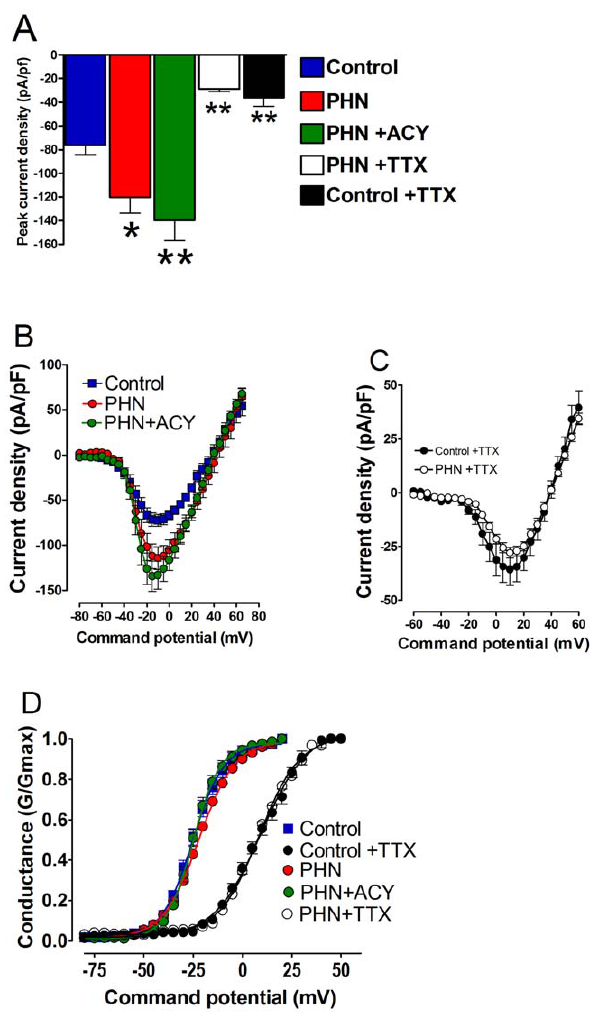
Figure 5. Pre-treatment with acyclovir does not prevent the TTX sensitive increase in sodium current density in ND7/23 1.8 cells induced by prior exposure to VZV isolates implicated in PHN. (A) Comparison peak current density in sham treated control cells (solid blue bar), cells exposed to VZV isolates implicated in post herpetic neuralgia (PHN, solid red bar), cells exposed to PHN VZV isolates and subsequently treated with acyclovir (solid green bar), the effect of TTX on cells exposed to PHN VZV isolates (open bar) and the effect of TTX on sham treated control cells (solid black bar) (sham treated control vs PHN * =p , 0.05; sham treated control vs PHN + ACY ** =p , 0.01; PHN vs PHN + TTX ** =p , 0.01, and sham treated control vs sham treated control + TTX ** =p , 0.01; Analysis of Variance Newman-Keuls multiple comparison post hoc test. (B) and (C) Conventional current density verses membrane potential plots for sodium currents from cells exposed to PHN VZV isolates vaccine strains: sham treated control cells (blue squares) and sham treated control cells following exposure to TTX (black circles); cells exposed to PHN viral isolates in the absence (red circles) and presence of TTX(open circles); and cells exposed to PHN viral isolates that had been pre-treated with acyclovir (green circles). Data was generated using the following protocol: V Hold = 2 120 mV to + 100 mV depolarized in 5 mV increments for 25 ms every 1 sec. (D) Data from (B) and (C) represented as conductance plots. Curves were generated and fitted using a standard Boltzman function. The Boltzman curves generated from data set (B) yielded similar maximal activation voltages (V K control = 2 23.9 6 1.6 mV; V K ACY = 2 20.9 6 2.9 mV; V K PHN = 2 22.1 6 2.3 mV) and similarly curves from data set (C) yielded similar half maximal activation voltages (V K control + TTX = + 9.2 6 1.9 mV; V K PHN + TTX =9.5 6 1.2